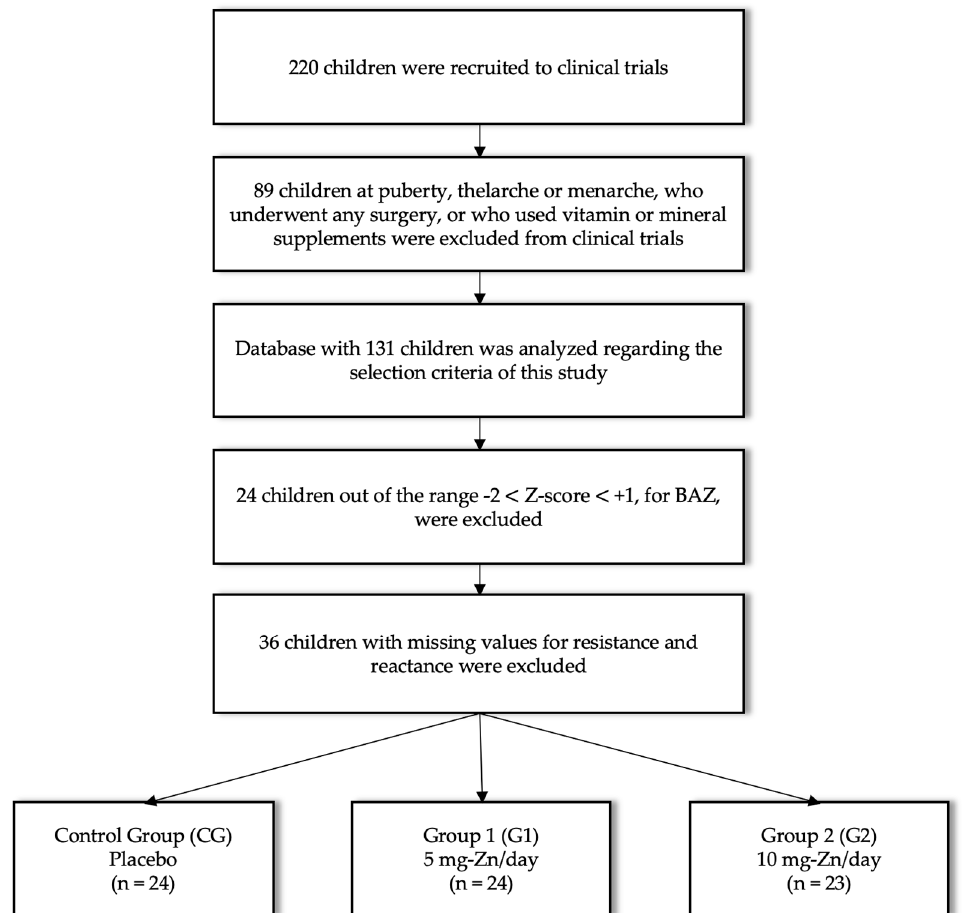
Figure 1. Recruitment flowchart with inclusion and exclusion procedures.